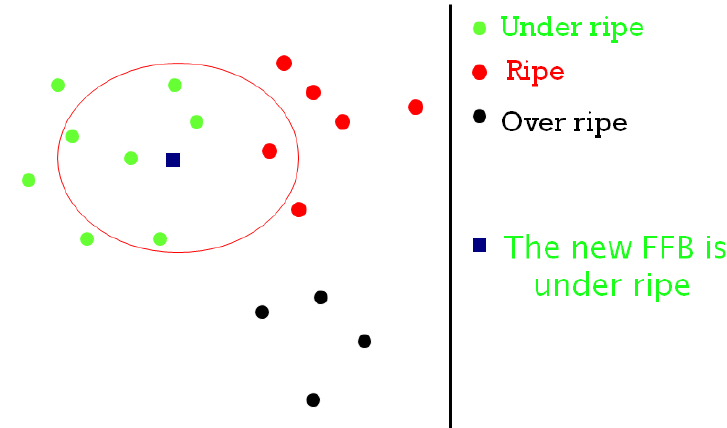
Figure 8. K-nearest neighbor (KNN) example with k = 6.